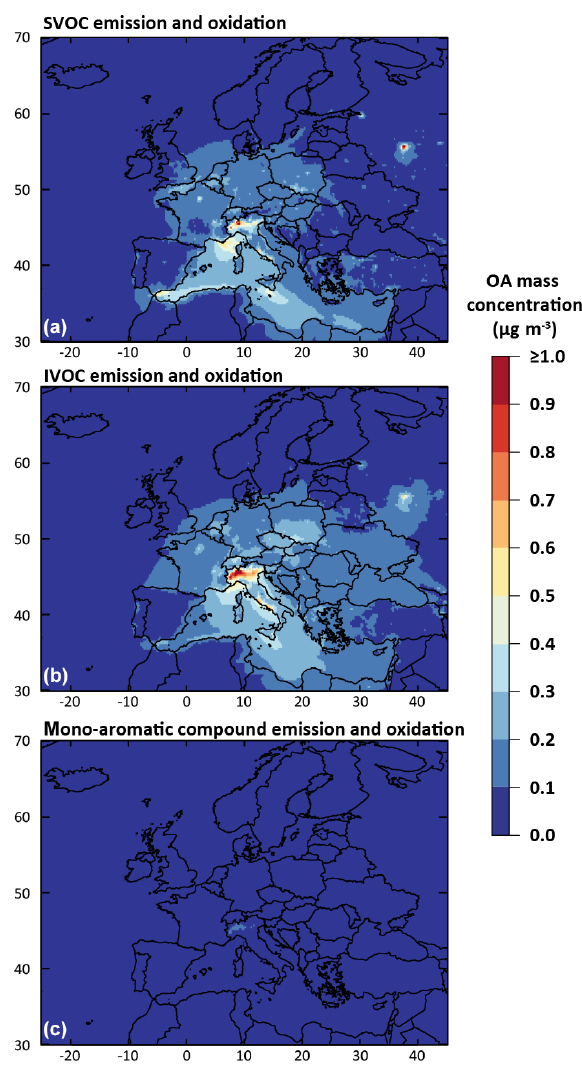
Figure 15. Mean simulated anthropogenic OA mass concentration formed by the partitioning of species produced from the oxida- tion of emitted traffic SVOCs (a) , traffic IVOCs (b) and mono- aromatic compound (c) for July–August 2013 over Europe (data from IVOC 30VOC